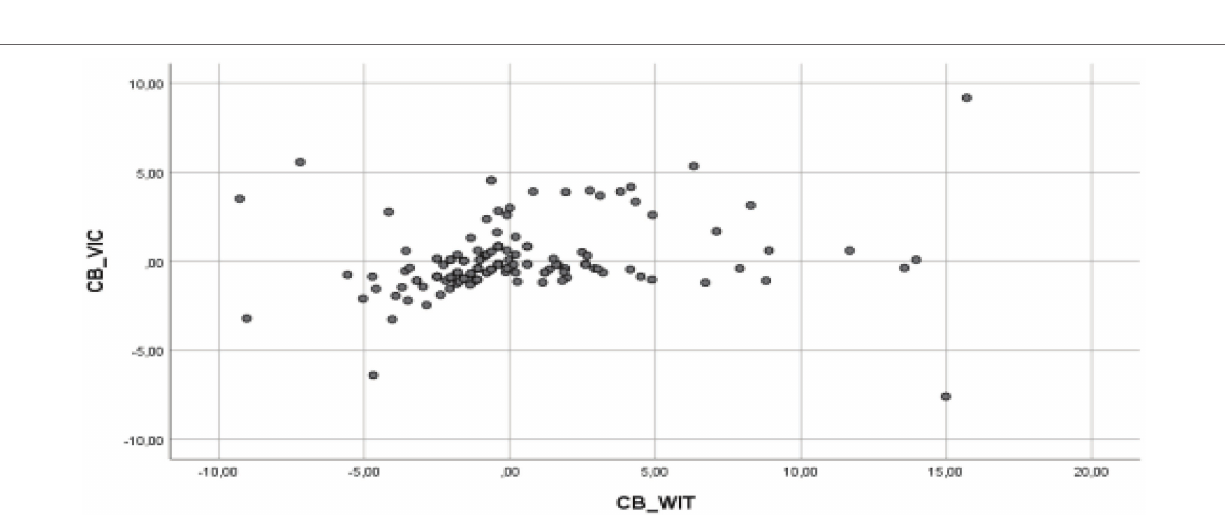
FIGURE 3 | Partial regression graphs of the cyberbullying role of victims criterion variable (CB_VIC), with the cyberbullying role of witnesses predictive variable (CB_ WIT), included in the